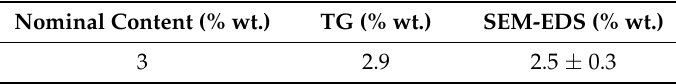
Table 1. Active phase content of PdCeHS samples.